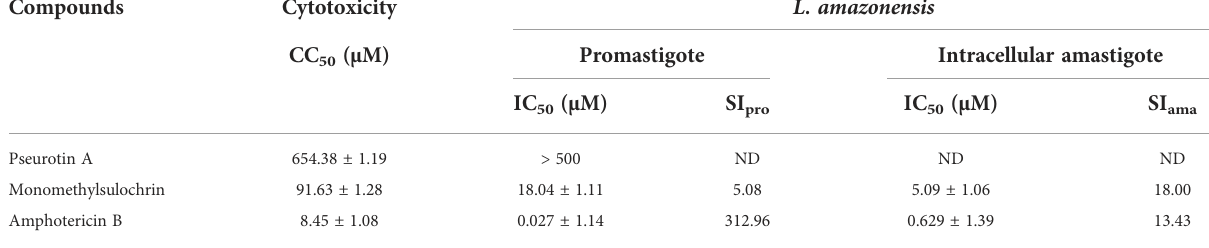
TABLE 1 Antileishmanial activity, cytotoxicity in BALB/c peritoneal macrophages, and selectivity index after 24h of treatment with compounds from Aspergillus sp. and amphotericin B.